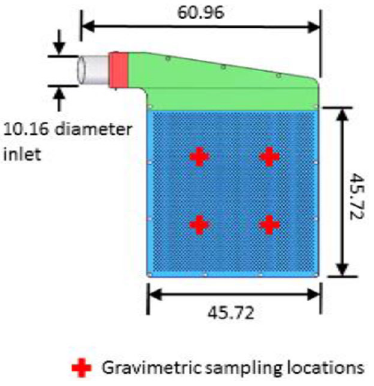
Fig. 5 The canopy air curtain showing gravimetric filter locations (measurements on figure are in centimeters)